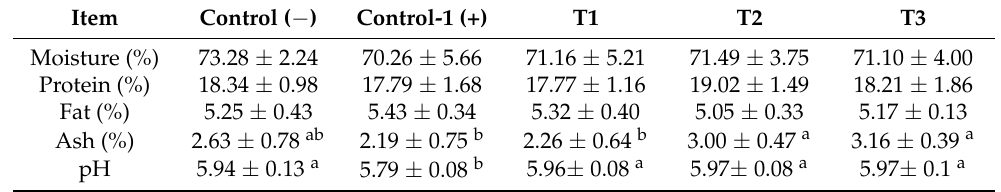
Table 2. Physicochemical characteristics of pork patties with fermented soy